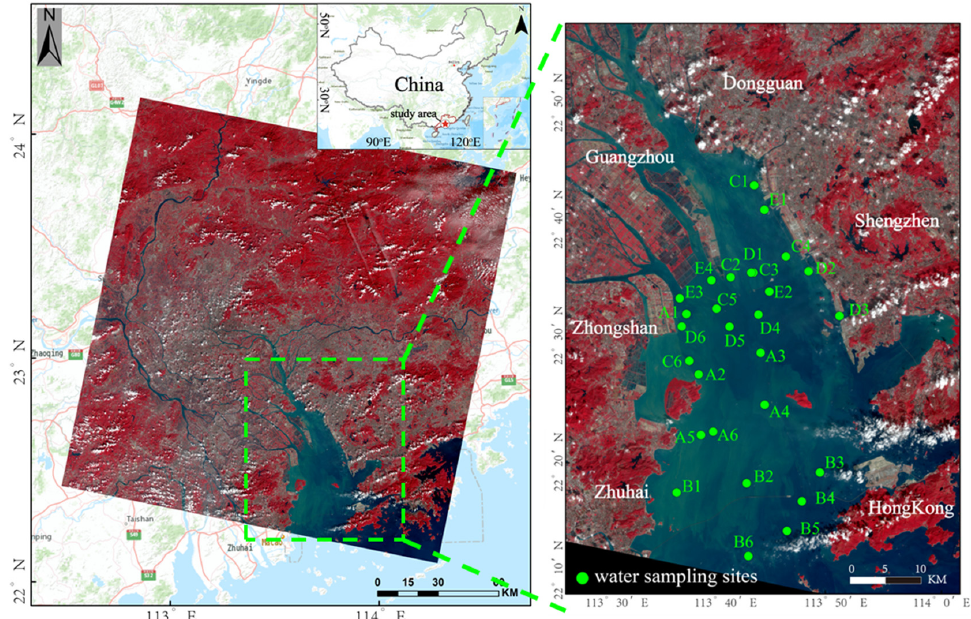
Figure 1. Study area and 35 water quality sampling points in the Pearl River Delta.